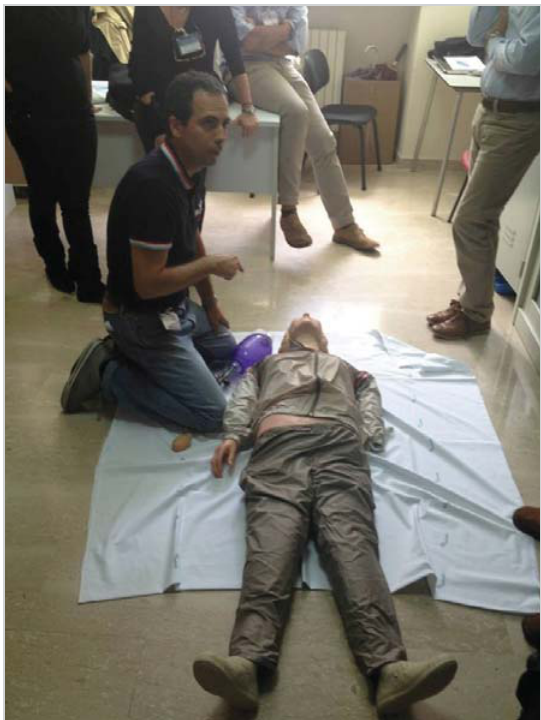
Figure 2. Dr. P. Poleggi during the training on Basic Life Support- Defibri- llation (BLS-D).